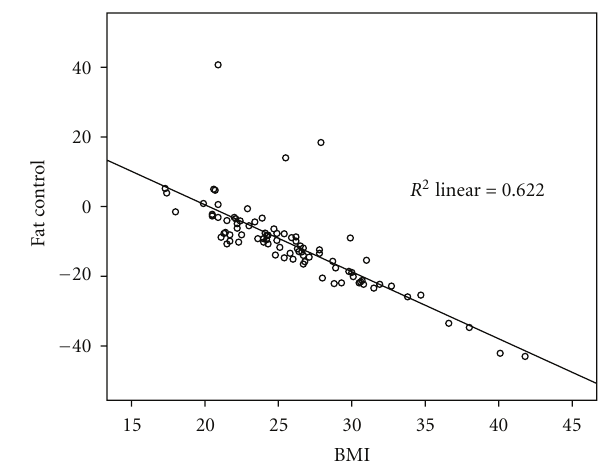
Figure 1: Plot of BMI versus fat